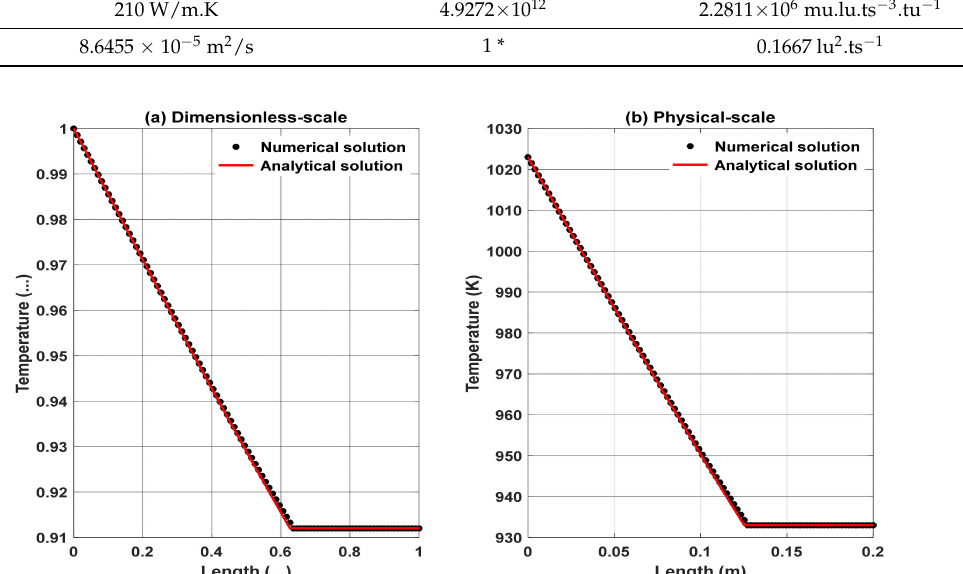
Figure 8. Temperature distribution along the slab for dimensionless time t ∗ = 1 (i.e., for 4.6267 × 10 2 s); ( a ) solution at the dimensionless-scale, and ( b ) solution at the physical-scale. The analytical solutions are achieved by using Equation (81)) at the dimensionless-scale and physical-scale. The numerical solution is achieved by using the LBM at the